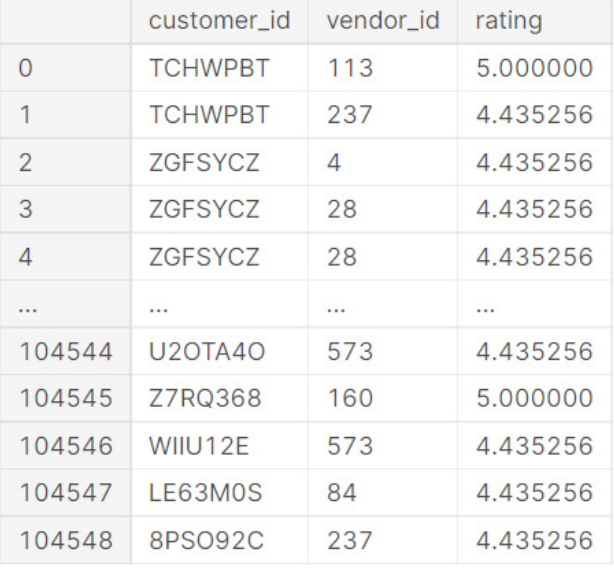
Figure 30. The processed order training dataset.